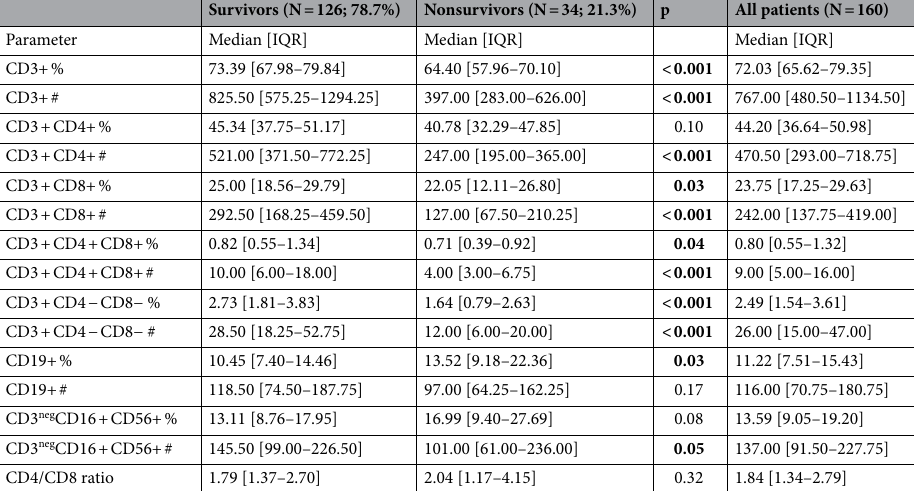
Table 2. T-, B- and NK-lymphocyte subpopulation relative and absolute counts at baseline in survivors and nonsurvivors. Statistically significant p values are highlited in bold. Reference values: CD3+ (%): 55–84; CD3+ (cells/µl): 690–2540; CD3 + CD4+ (%): 31–60; CD3 + CD4+ (cells/µl): 410–1590; CD3 + CD8+ (%): 13–41; CD3 + CD8+ (cells/µl): 190–1140; CD19+ (%): 5–25; CD19+ (cells/µl): 90–660; CD3 neg CD16 + CD56+ (%): 5–27; CD3 neg CD16 + CD56+ (cells/µl): 90–590; CD4/CD8 ratio: 1.5–2.5 Subpopulation relative counts are expressed as the percentages of total lymphocytes. Differences between groups were assessed using the Mann–Whitney U test. A two-sided p value of < 0.05 was considered statistically significant. IQR interquartile